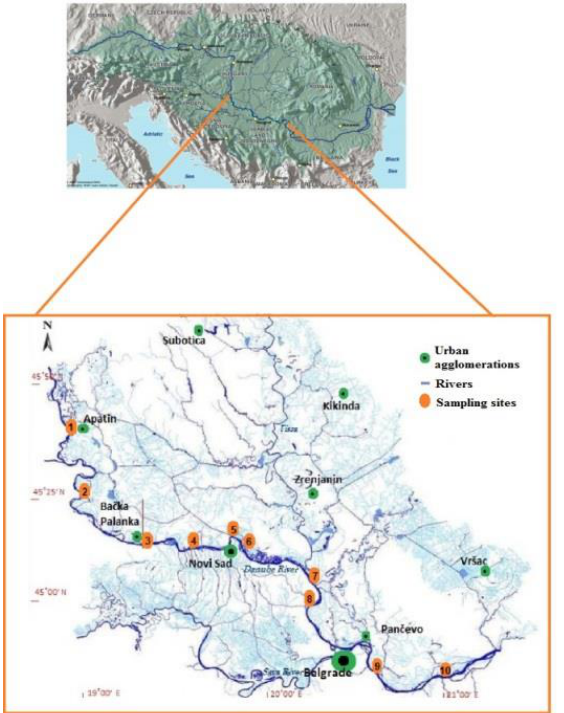
Figure 1. Danube River sampling